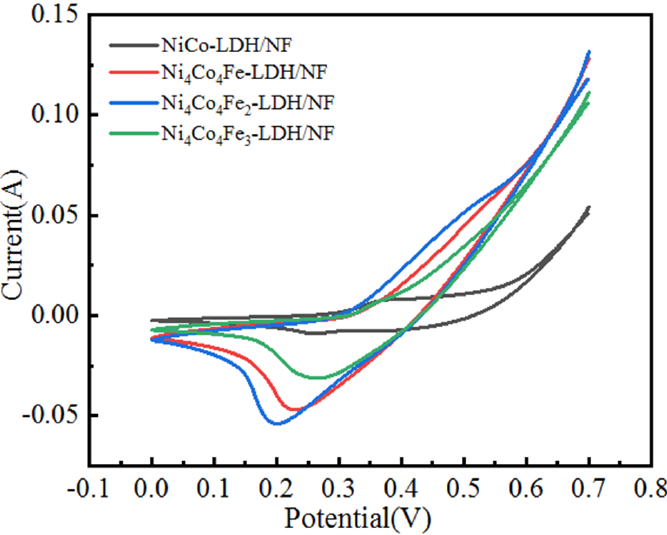
Figure 9. CV curves of Ni − Co based LDH electrode catalysts at the scan rate of 10 mV/s.